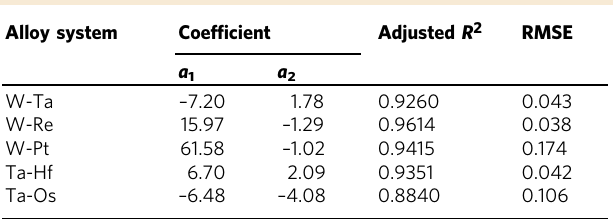
Table 1 Coef fi cients and accuracies of the linear regression